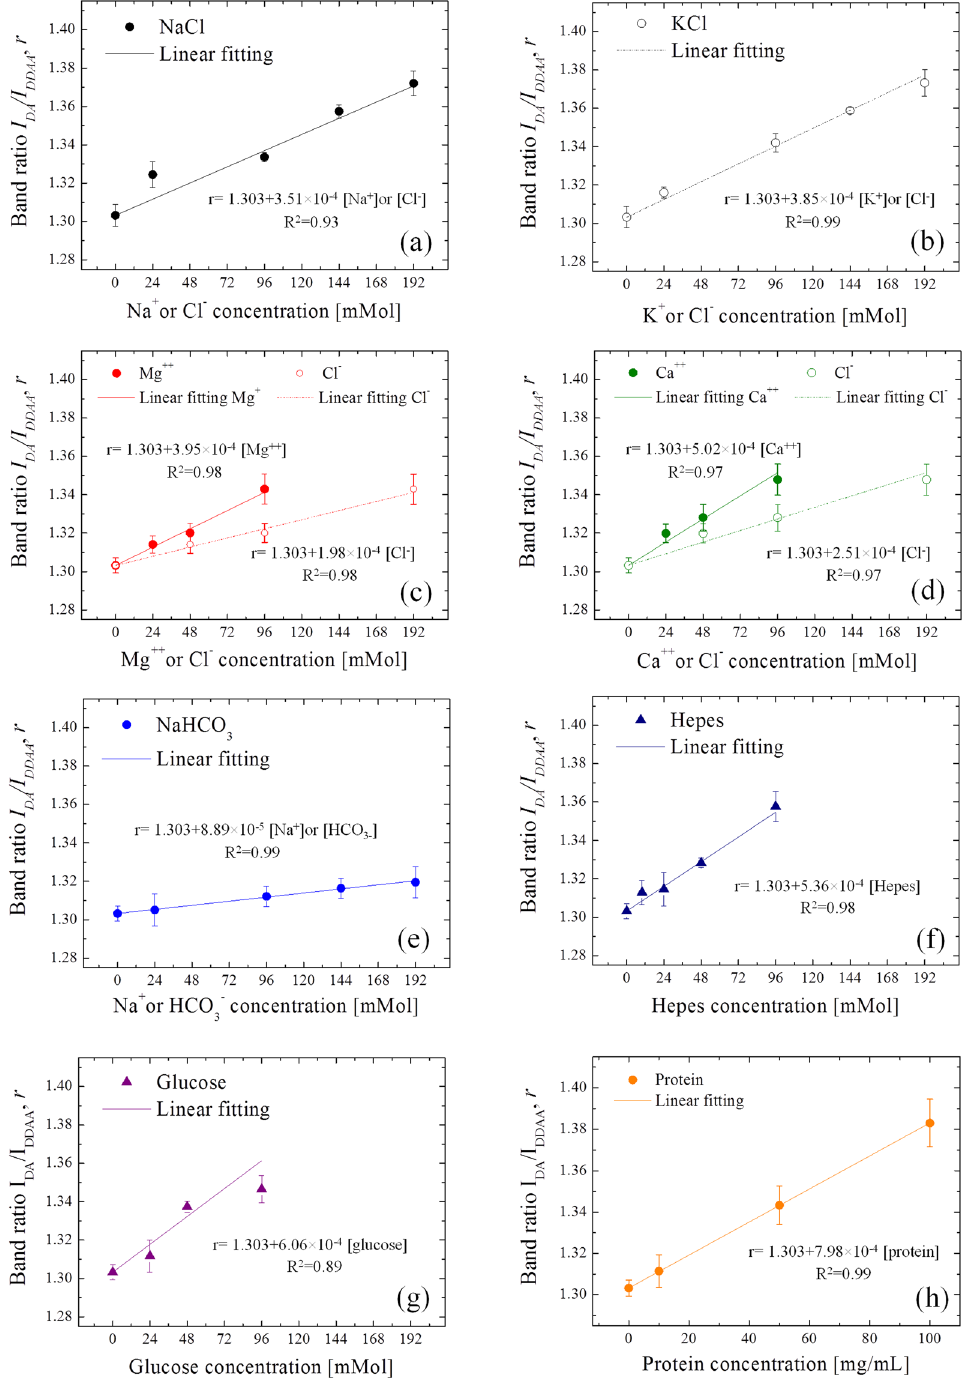
Figure 4. Liner dependence between the ionic concentration and the intensity ratio of the bands DA and DDAA, r = I DA /I DDAA , for solutions of NaCl ( a ), KCl ( b ), MgCl 2 ( c ), CaCl 2 ( d ), NaHCO 3 ( e ), Hepes ( f ), glucose ( g ) and proteins (bovine serum albumin) ( h